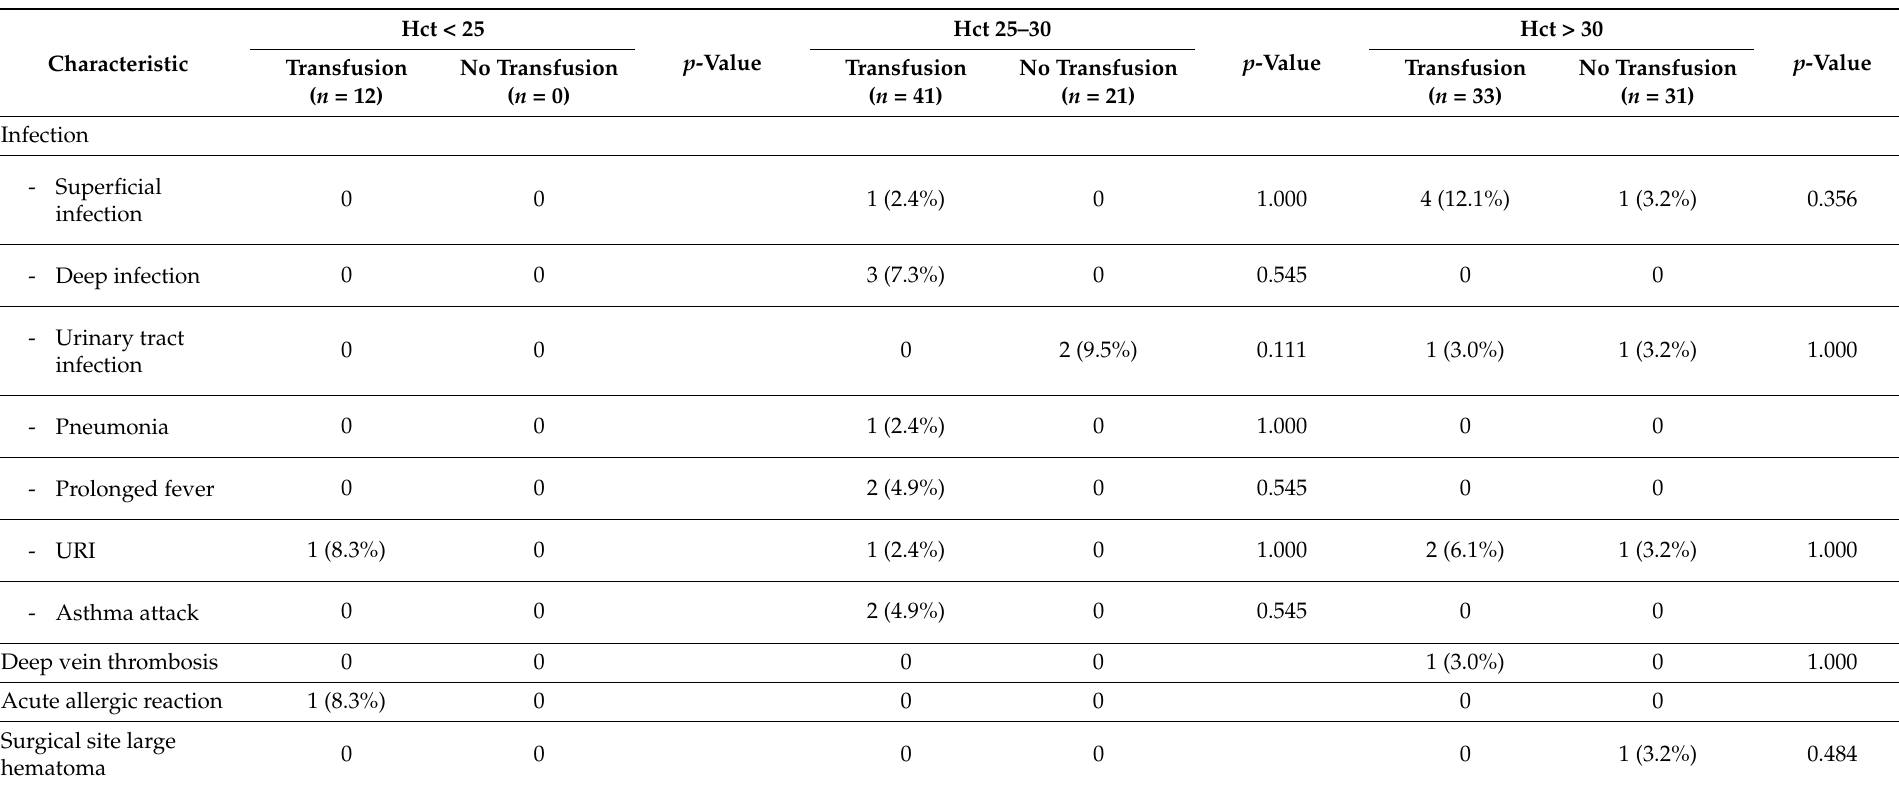
Table 4. Incidence of postoperative complications at 30 days following pediatric hip